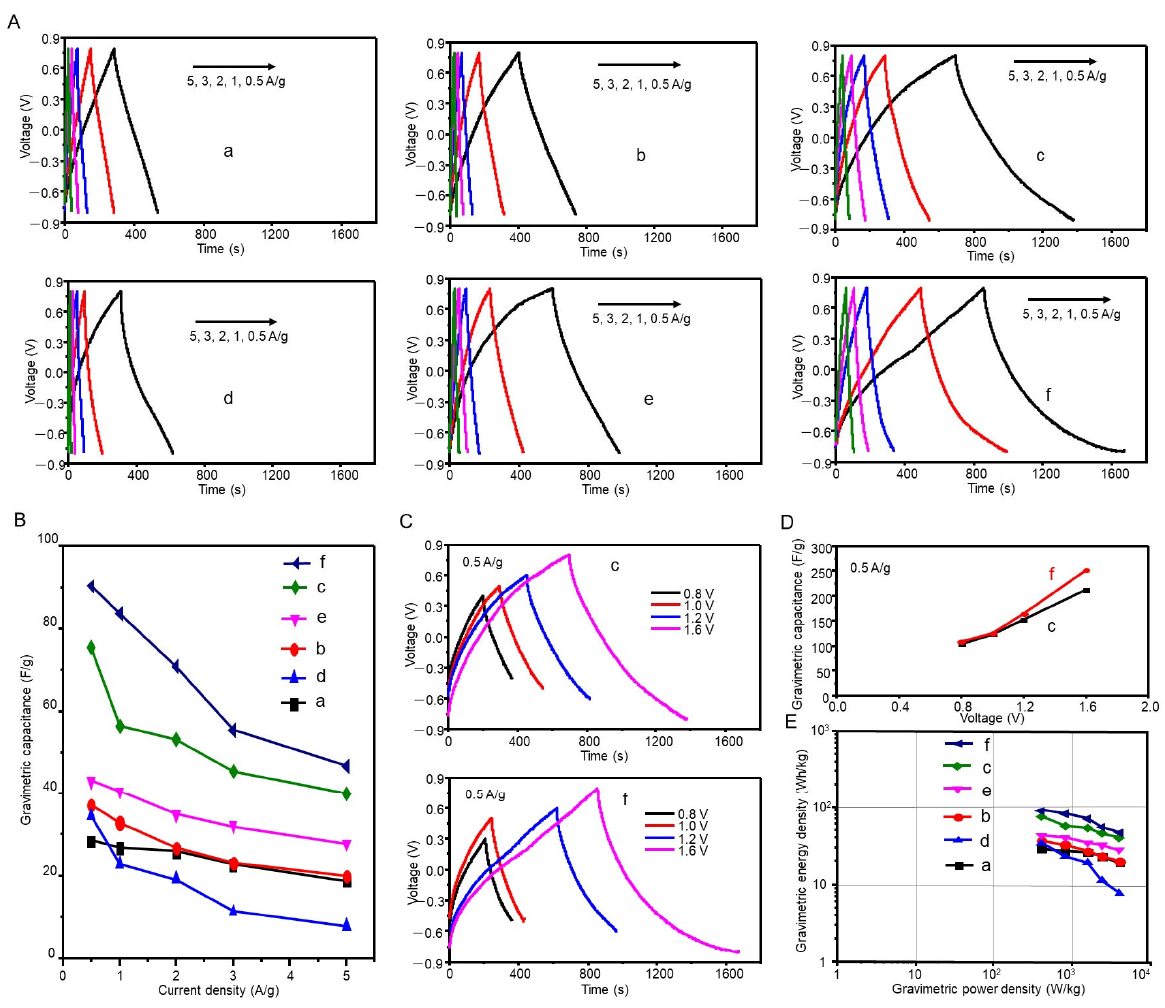
Figure 6. ( A ) The GCD profiles at different current densities and ( B ) gravimetric capacitances as a function of current density of (a ‐ c) symmetric and (d ‐ f) asymmetric supercapacitors. ( C ) The GCD profiles for different potential windows and ( D ) gravimetric capacitances as a function of potential window of (c) symmetric and (f) asymmetric supercapacitors at 0.5 A/g current density. ( E ) Ragone plots of (a ‐ c) symmetric and (d ‐ f) asymmetric supercapacitors. Supercapacitors: (a) (NG/Fe 3 O 4 )//(NG/Fe 3 O 4 ), (b) (NG/Cdots)/NG/Cdots), (c) NG/Cdots/Fe 3 O 4 )//(NG/Cdots/Fe 3 O 4 ), (d) (NG/Cdots)//(NG/Fe 3 O 4 ), (e) (NG/Cdots)//(NG/Cdots/Fe 3 O 4 ) and (f) (NG/Fe 3 O 4 )//(NG/Cdots/Fe 3 O 4 ).